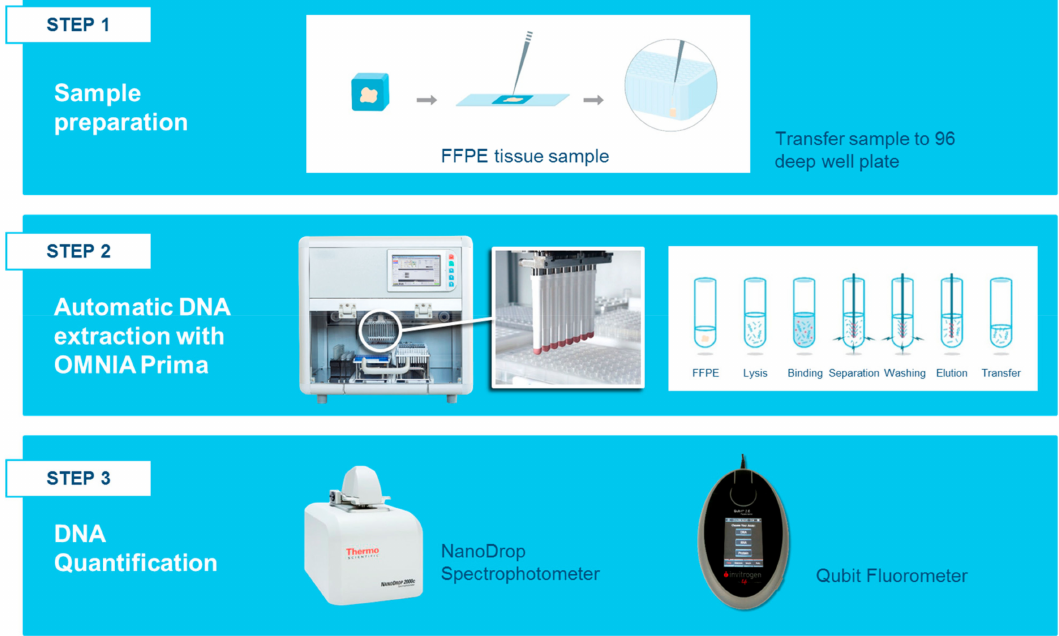
Figure 10. Workflow DNA analysis using the OMNIA Prima automated workstation. Step 1 shows the manual transfer to a well of the processing plate (96 deep-well plate) for each sample. Step 2 represents the fully automatic DNA extraction by the OMNIA Prima workstation. The magnetic tool of the workstation was used to catch the DNA charged beads and to wash and elute the DNA. Step 3 indicates the preliminary evaluation methods used to quantify the nucleic acids before NGS library